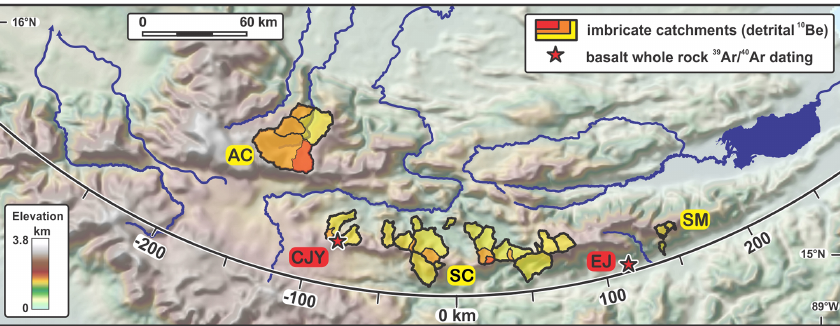
Figure 6. Catchments sampled for the 10 Be analysis (AC: Altos de Cuchumatanes; SC: Sierra de Chuacús; SM: Sierra de las Minas) and 40 Ar / 39 Ar dating (CJY: Chujuyúb; EJ: El Jute). Enlarged maps of the catchments and their lithologies are provided in Fig. S2-1 in the Supplement). The arcuate line represents the axis used for plate-boundary-parallel projections of Figs. 10 and